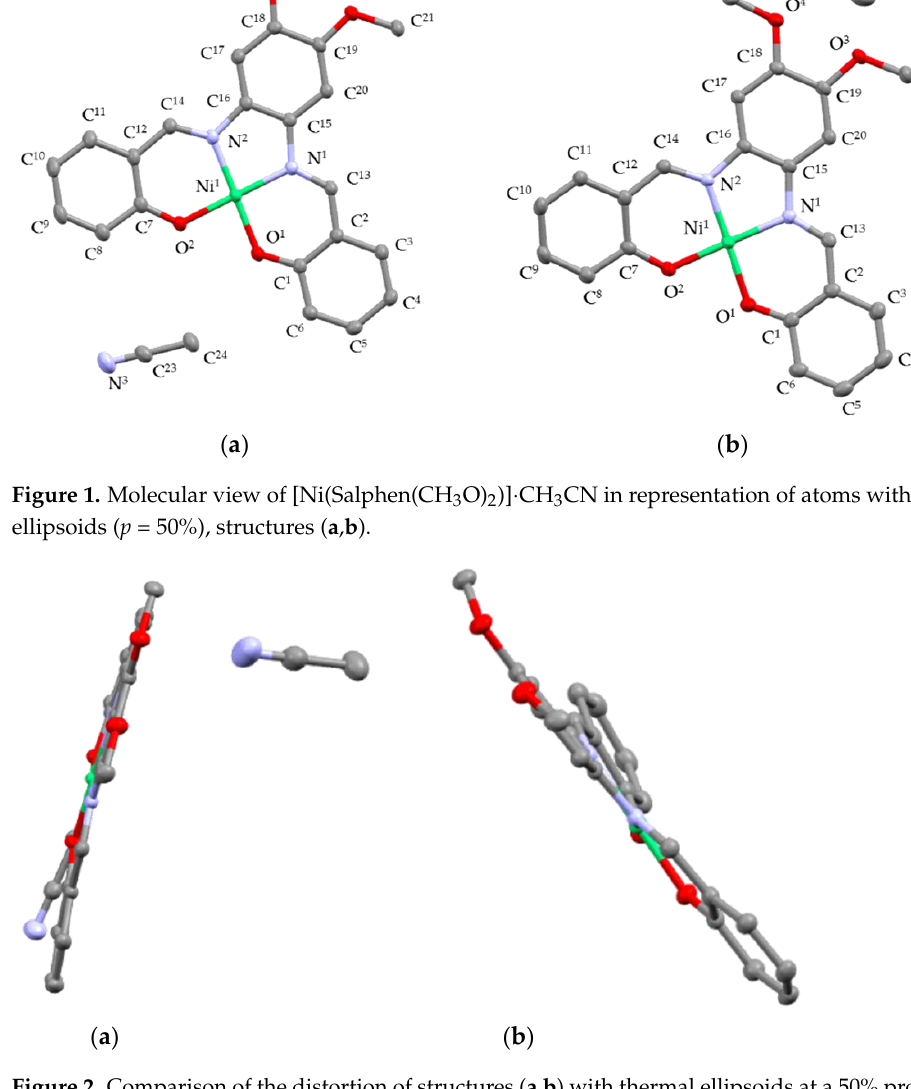
Figure 2. Comparison of the distortion of structures ( a , b ) with thermal ellipsoids at a 50% probabil- ity.